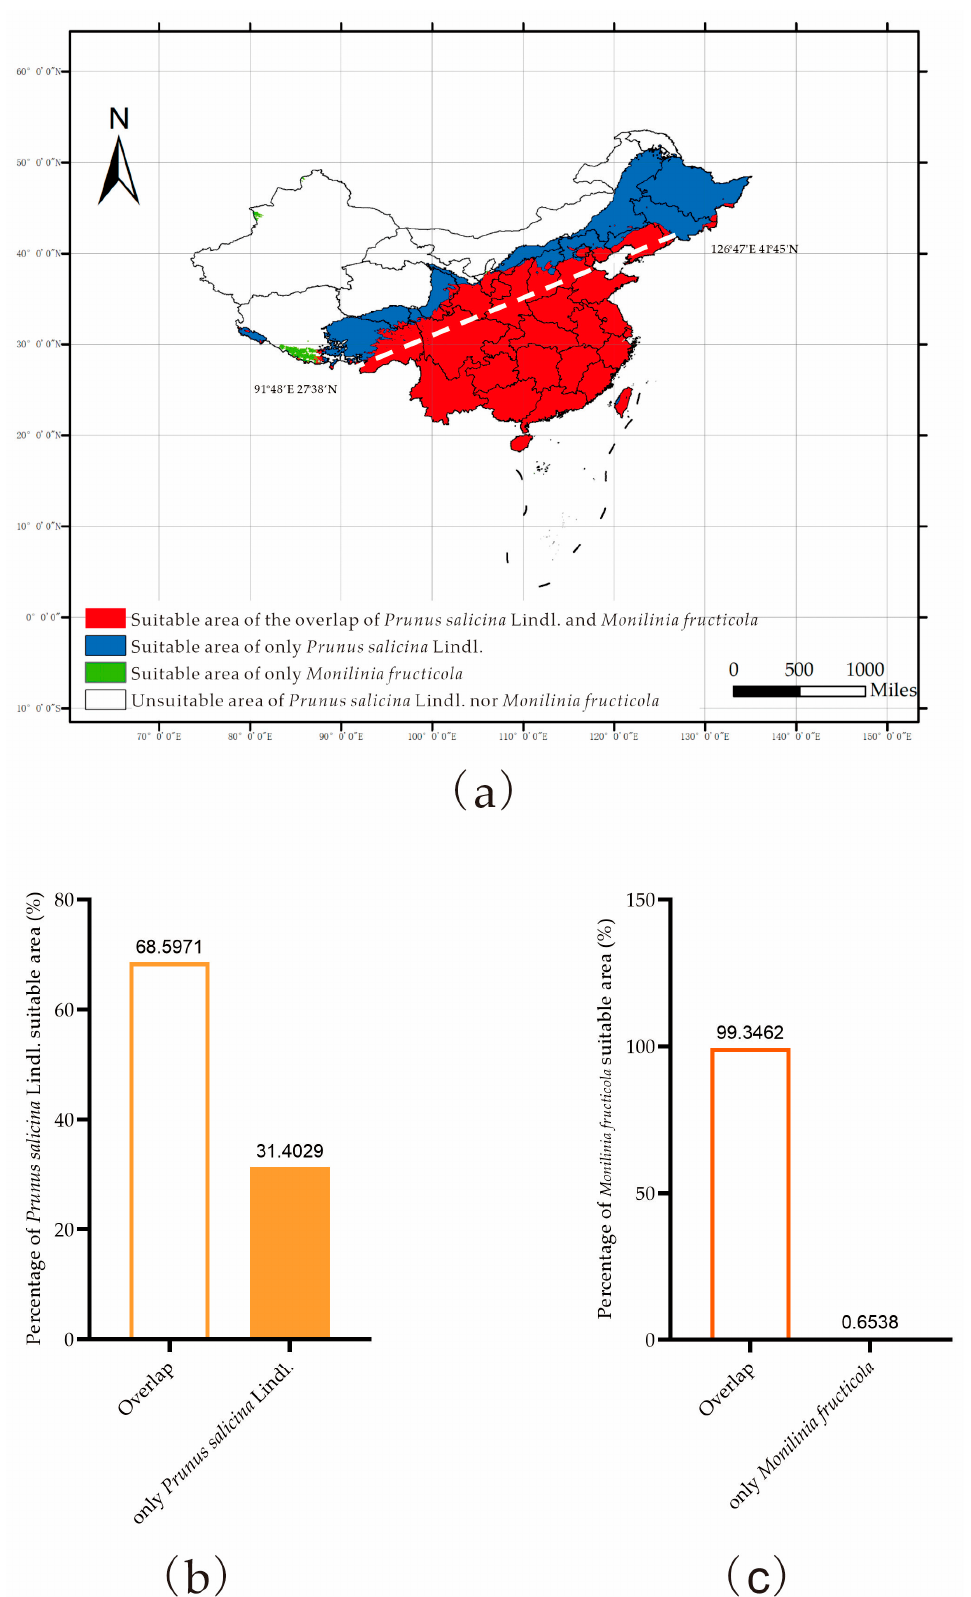
Figure 7. Hot spot map of distribution consistency between P. salicina and M. fructicola in China ( a ) and their percentage of suitable areas ( b and c ).